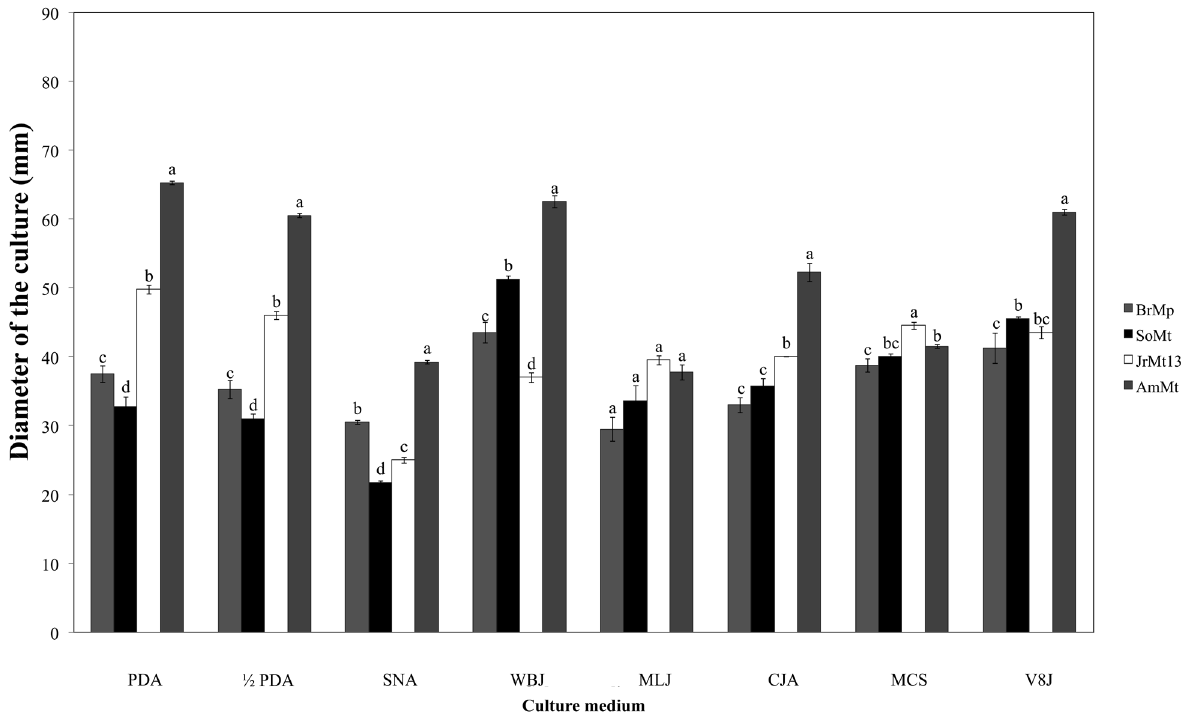
Figure 1. Growth of four strains of Cercospora medicaginis on different solid media. Potato dextrose agar (PDA and ½ PDA), synthetic nutrient-poor agar (SNA), wheat bran juice (WBJ), Medicago leaf juice (MLJ), carrot juice agar (CJA), Medicago crushed seed (MCS) and V8 juice